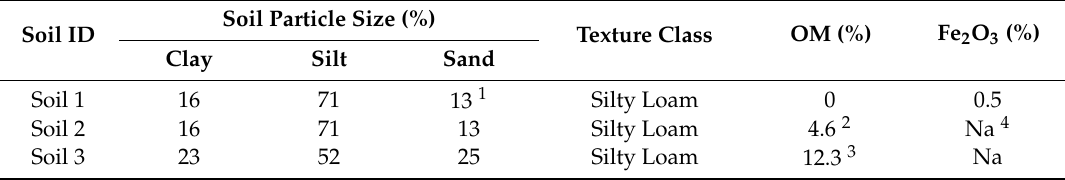
Table 1. The soils used in this study. Soils 2-3 (low and high organic matter (OM)) were collected from Limburg province in The Netherlands. Soil 1 (no OM and added hematite) was obtained from Soil 2. Soil Particle Size Soil ID